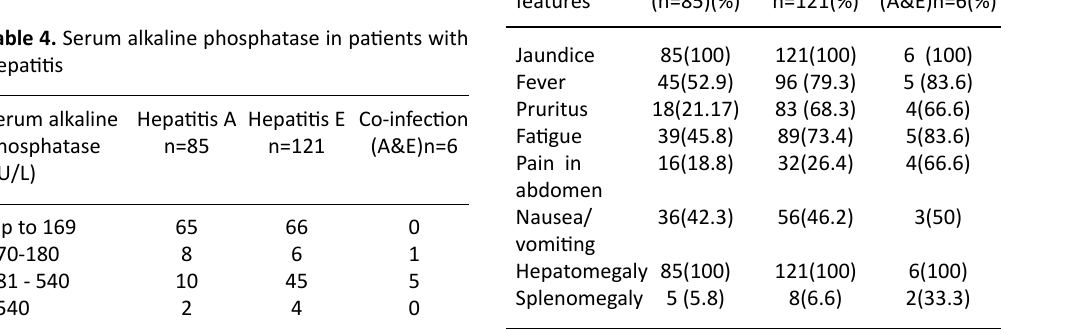
Table 5. Clinical features